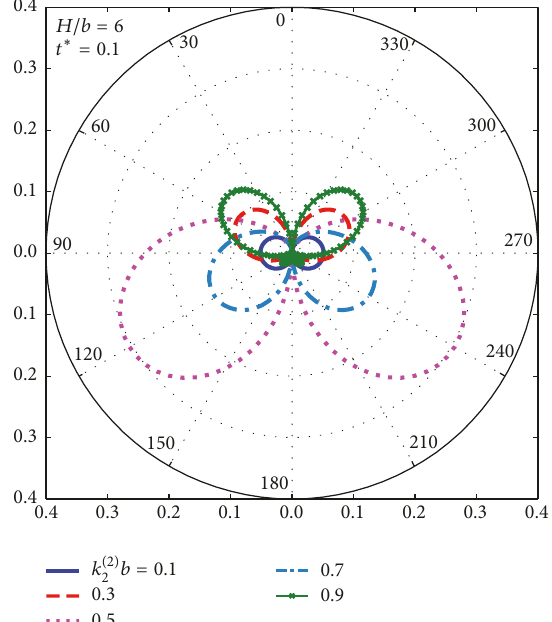
Figure 3: Tangential displacement (𝑢 ∗ 𝜃 ) versus polar angle at 𝑟 = 𝑏 for different wave numbers (𝑘 (2) 2 𝑏) for a tunnel in hard